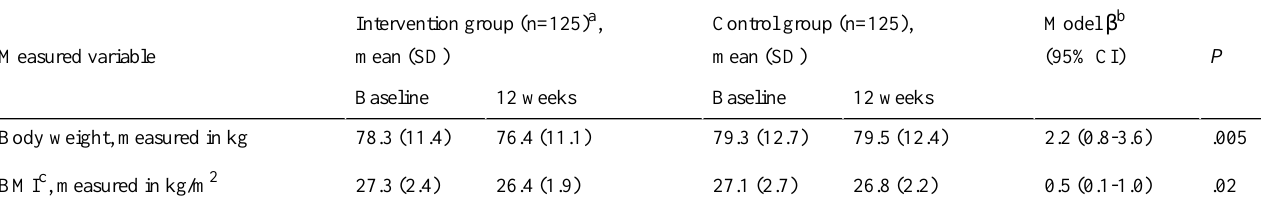
a All participants had measured variables including 2 participants who did not complete baseline self-report surveys. b Model coefficients and P values were obtained from analysis of covariance models adjusting for baseline values, general practitioner clinic, and gender. Missing baseline and follow-up values were imputed to create five datasets and results were pooled using Rubin’s rules. c Body mass index